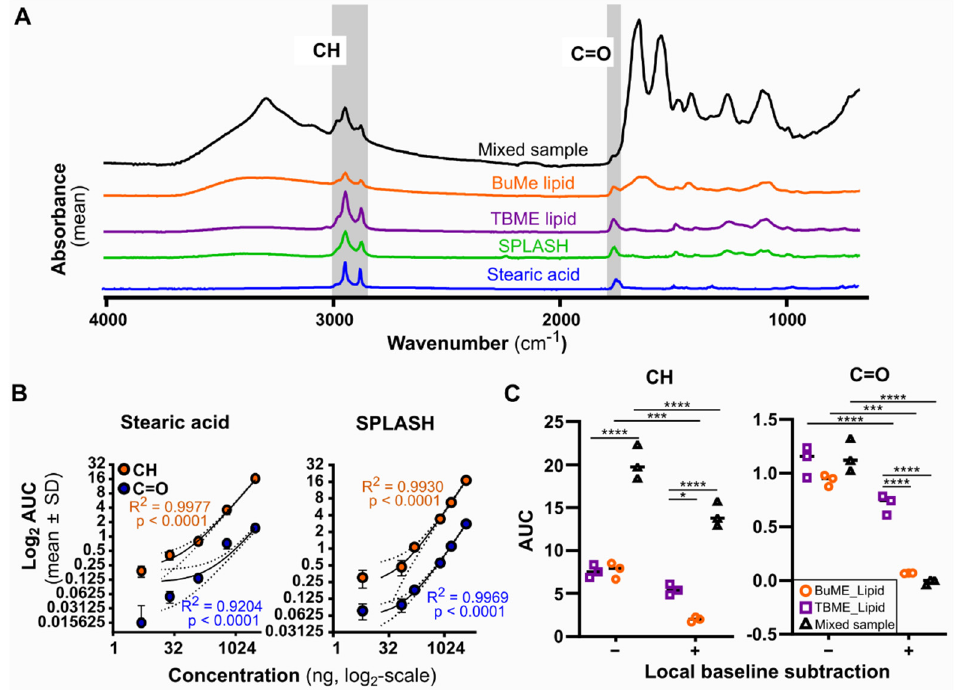
Figure 2. Assessment of lipid quantification by ATR-FTIR spectroscopy—impact of different extrac- tion methods, standards, and spectral processing. ( A ) Analysis of spectral features in extracted (BuMe, TBME) or commercial lipid (SPLASH, stearic acid) samples. Hydrocarbon (3000–2800 cm − 1 ) and ester (1760–1710 cm − 1 ) regions are highlighted in gray. ( B ) Titration of lipid standard by simple fatty acid (stearic acid) or complex lipid mixtures (SPLASH), expressed as a log–log graph. Linear regression analysis was performed between the area under the curve (log 2 AUC) of the CH and C=O regions and known lipid quantities (log 2 ). n = 3. Linear regression was fitted, displaying 95% confidence interval. ( C ) Area under the curve (AUC) measurements of the CH and C=O regions either with (+) or without ( − ) local baseline subtraction; see Methods Section 2.8 for formula. Two-sided two-way ANOVA compared between measurements, where * p < 0.05, *** <0.001, **** <0.0001. Table 1. Characteristics of two different ATR-FTIR lipid calibration curves. Stearic Acid